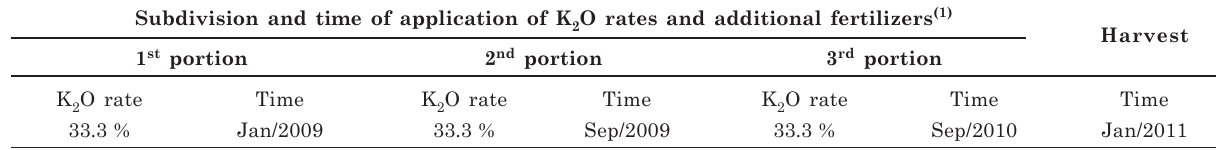
(1) A supplementary fertilizer rate (80 kg ha -1 of N and P